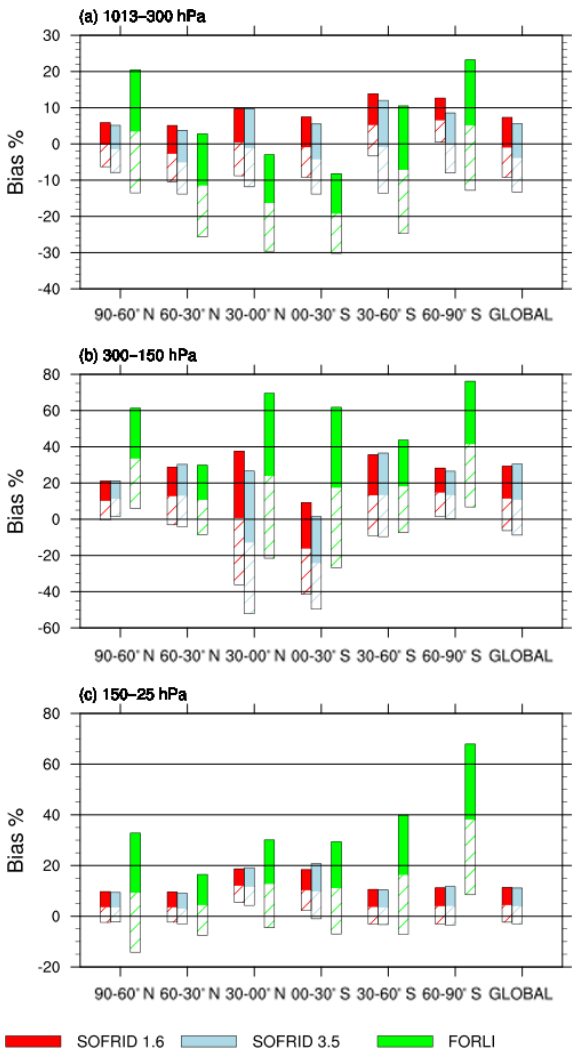
Figure 15. Biases and ± RMSDs (bars) of the differences between IASI retrievals and sonde data. Red indicates SOFRID-O3 v1.6, light blue indicates SOFRID-O3 v3.5, and green indicates FORLI- O3 (from Boynard et al.,